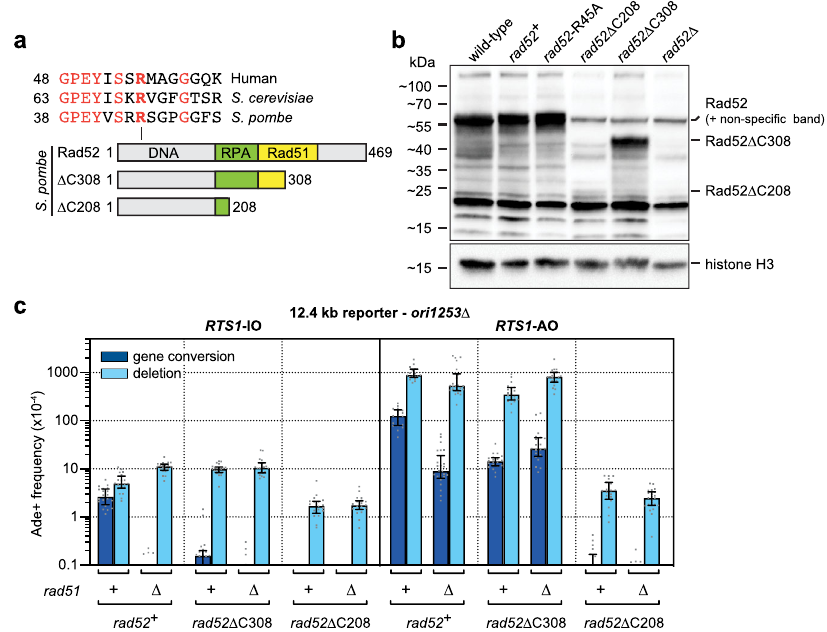
Fig. 4 | Rad52 ’ s N-terminal DNA binding domain is required for Rad51- independent template switching. a Schematic showing the main interaction domains and conserved arginine-45 in fi ssion yeast Rad52. The two C-terminal truncations, Δ C308and Δ C208,arealsoshown. b Westernblotshowingtherelative amounts of full length and truncated Rad52 in whole cell extracts from wild-type (MCW8888), rad52 + - kanMX6 (MCW9694), rad52 -R45A- kanMX6 (MCW9840), rad52 Δ C208- kanMX6 (MCW9692), rad52 Δ C308- kanMX6 (MCW9693) and rad52 Δ